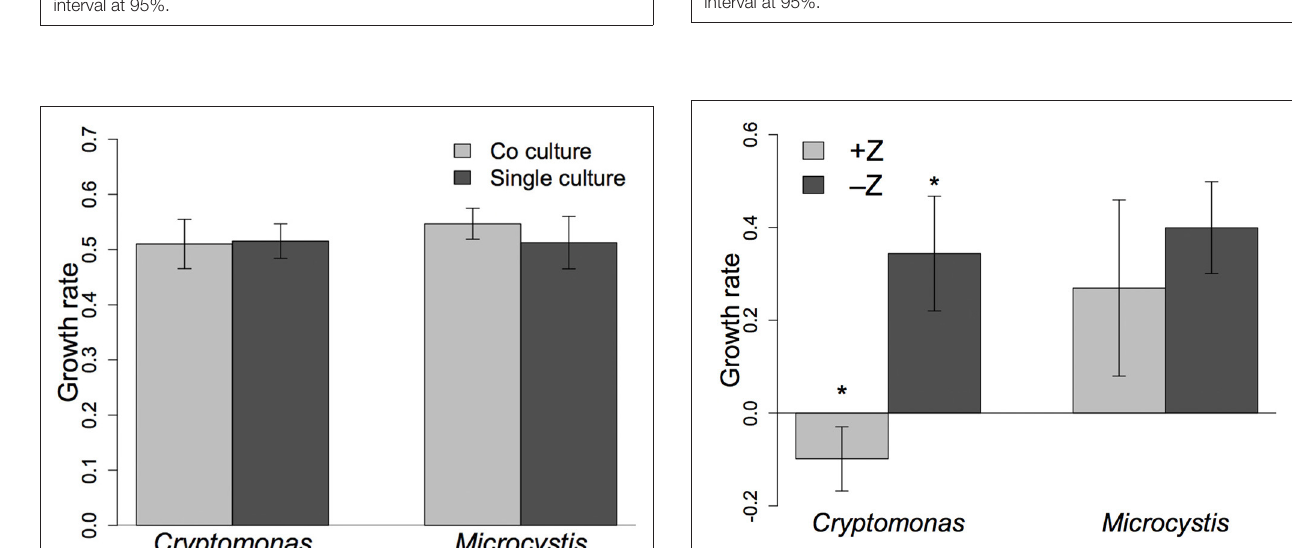
FIGURE 3 | Temporal trend of mean cell density for Cryptomonas (A) and Microcystis (B) in the facilitation experiment showing the mean cell density (cell.mL − 1 ) measured in no-grazer controls (empty circles, n = 4) and treatments with grazers (solid circles, n = 4). Error bars represent confidence interval at 95%.